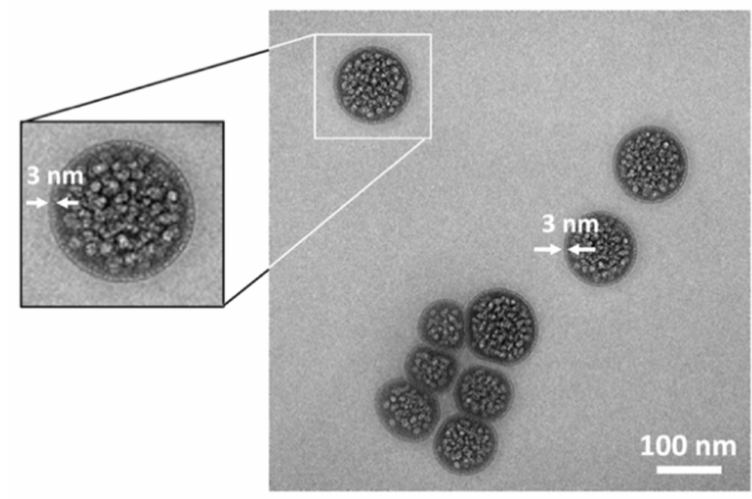
Figure 2. Transmission electron micrographs of P1 liposomal formulation of Photolon, where photosensitizer is uniformly distributed inside of nanovesicle. The single spheroidal lipid bilayer is about 3 nm thick.